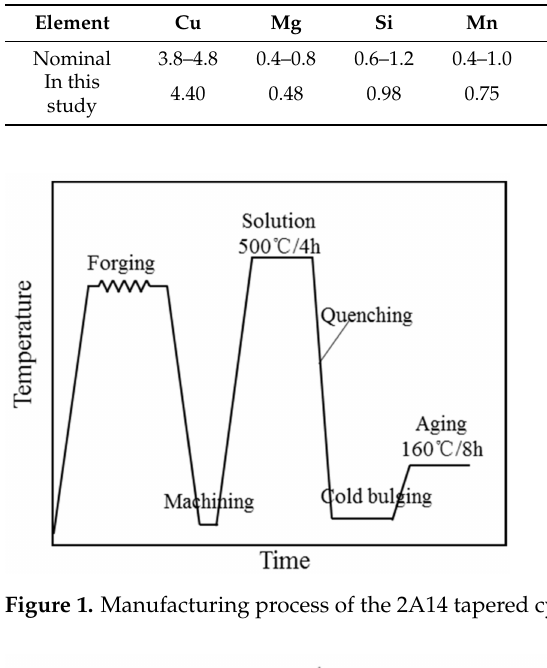
Table 1. Chemical compositions of 2A14 aluminum alloy (wt%).